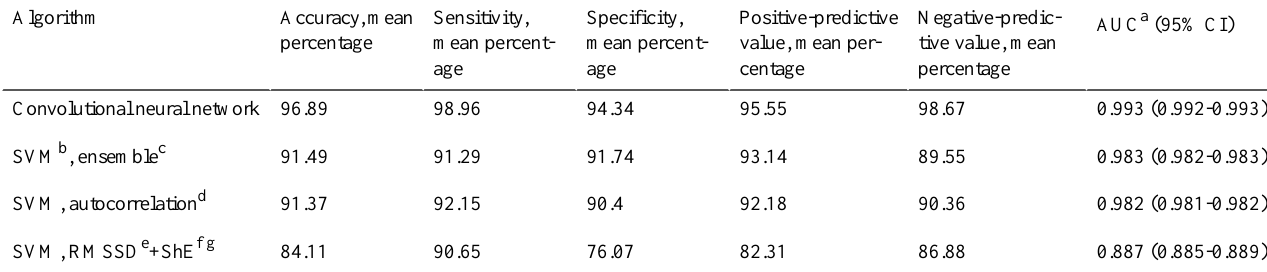
Table 2. Diagnostic performance of the ring according to algorithms.